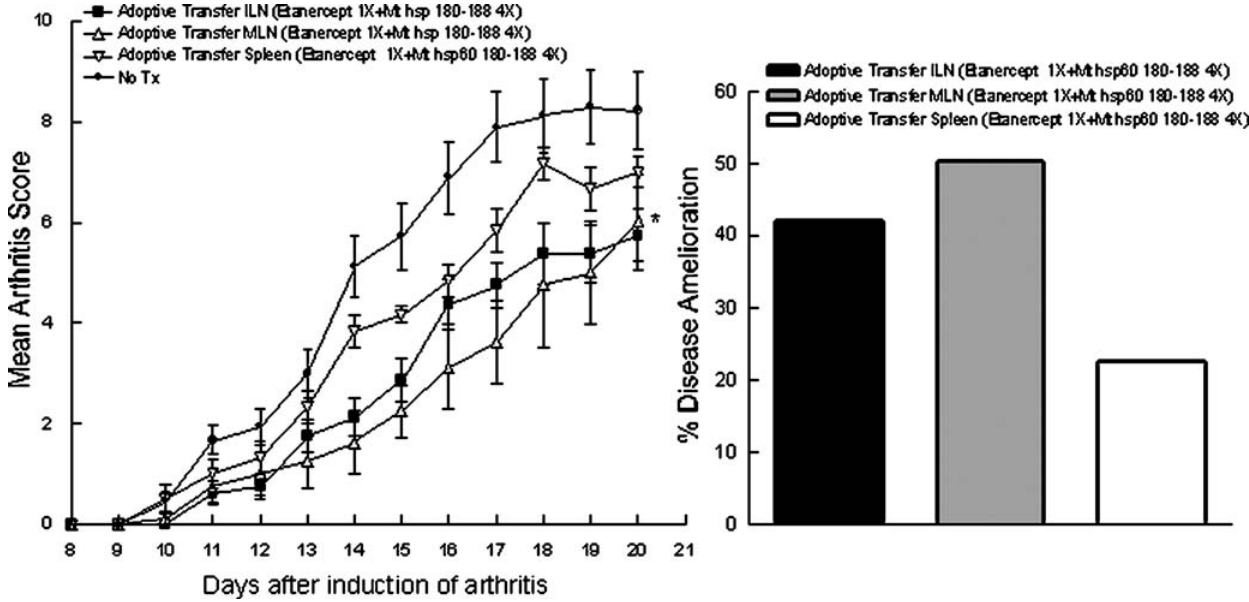
Figure 5. Adoptive Transfer of Mandibular Lymphnode (MLN) T cells from Combination Therapy treated animals led to significant reduction of Adjuvant Arthritis (AA) in diseased animals, measured as Mean Arthritis Score as well as percentage of Disease Amelioration. A. Adoptive Transfer of T cells from Combination Therapy groups. Adoptive Transfer Groups received 11 6 10 6 Inguinal Lymphnode (ILN) cells, 13 6 10 6 MLN cells, or 11 6 10 6 spleen cells. Data represent Mean 6 SD. Disease induction and scoring was performed as described in the legend to Figure 1. B. Percentage of Clinical Amelioration for each treatment group in AA rats . The Area Under the Curve (AUC) of each individual treatment group was used to score the Clinical Amelioration (CA) of the distinct treatment groups. AUC was calculated using the curves originated by scoring the disease for the different treatment groups and plotted as percentage of CA with respect to the non-treated group. The non-treated group was considered as having an average percentage of disease=100%. Formula is as follows: CA=100 - %AUC.